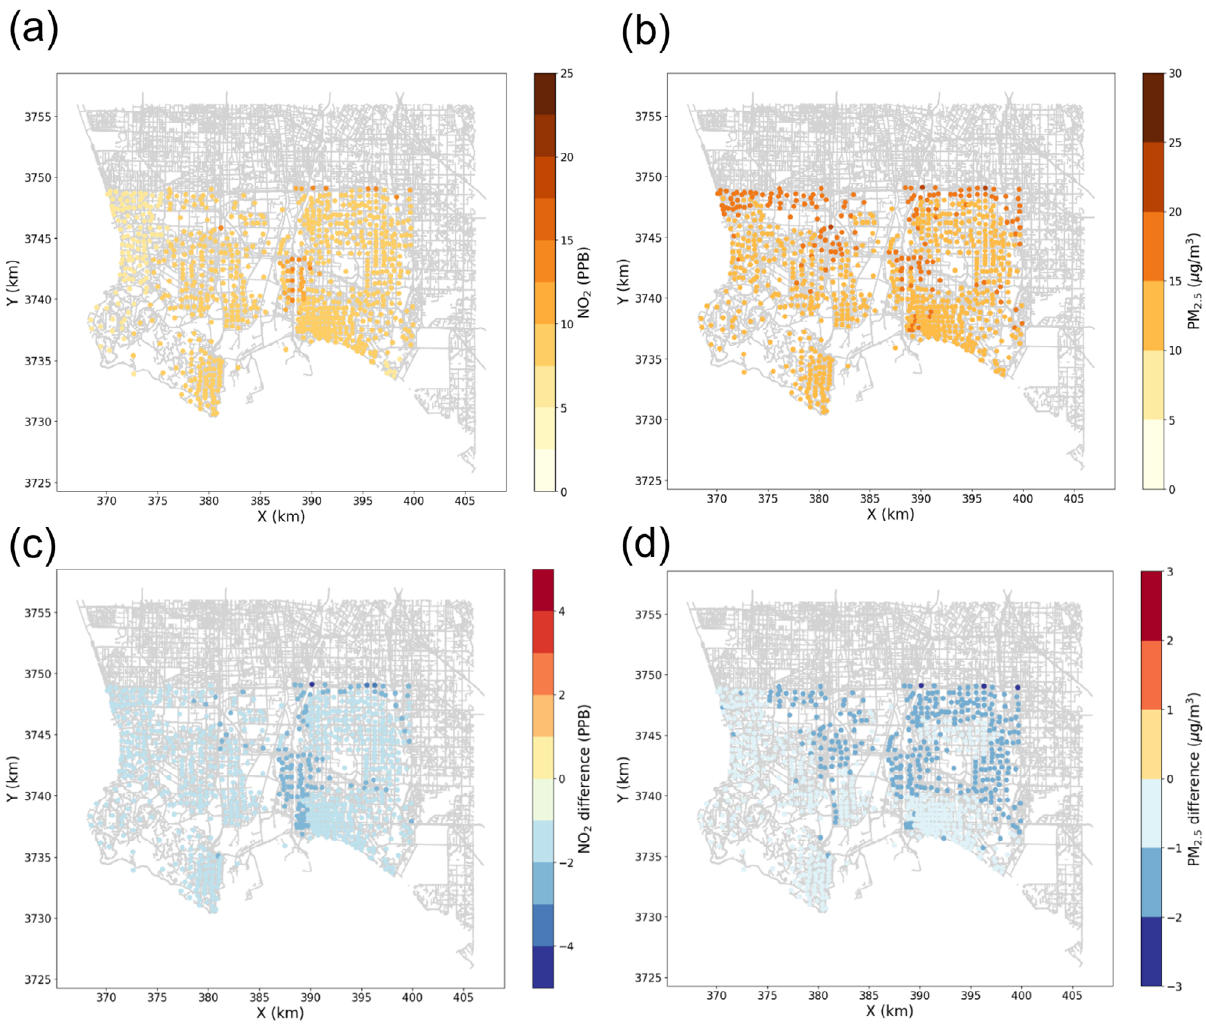
Fig. 3 Modeled NO 2 and PM 2.5 concentrations and concentrations differences. a NO 2 concentrations in the Reference Case, b PM 2.5 concentrations in the reference case, c NO 2 concentration differences between Scenario 5 and Reference Case, d PM 2.5 concentration differences between Scenario 5 and Reference. The circles represent census block group centroids, and the gray lines represent